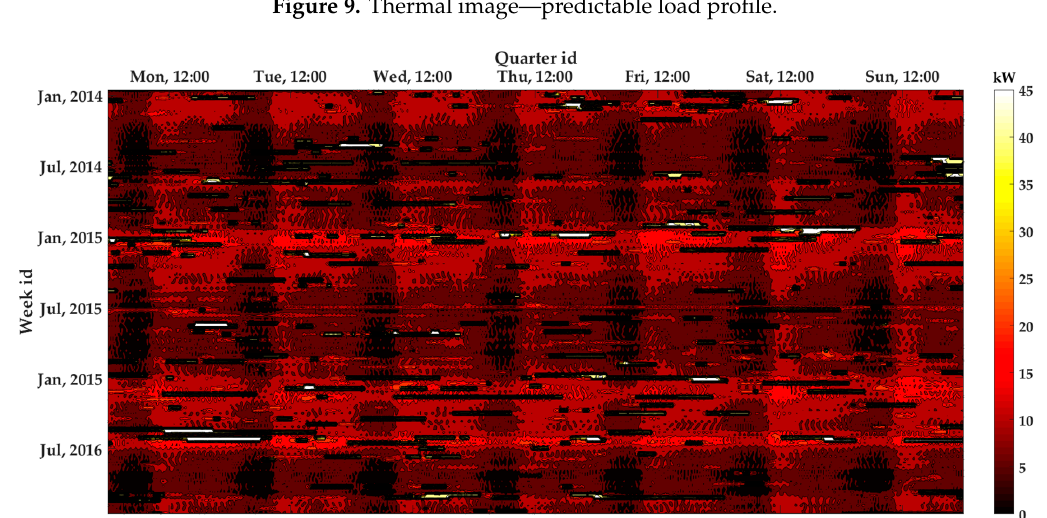
Figure 10. Thermal image—unpredictable load profile.